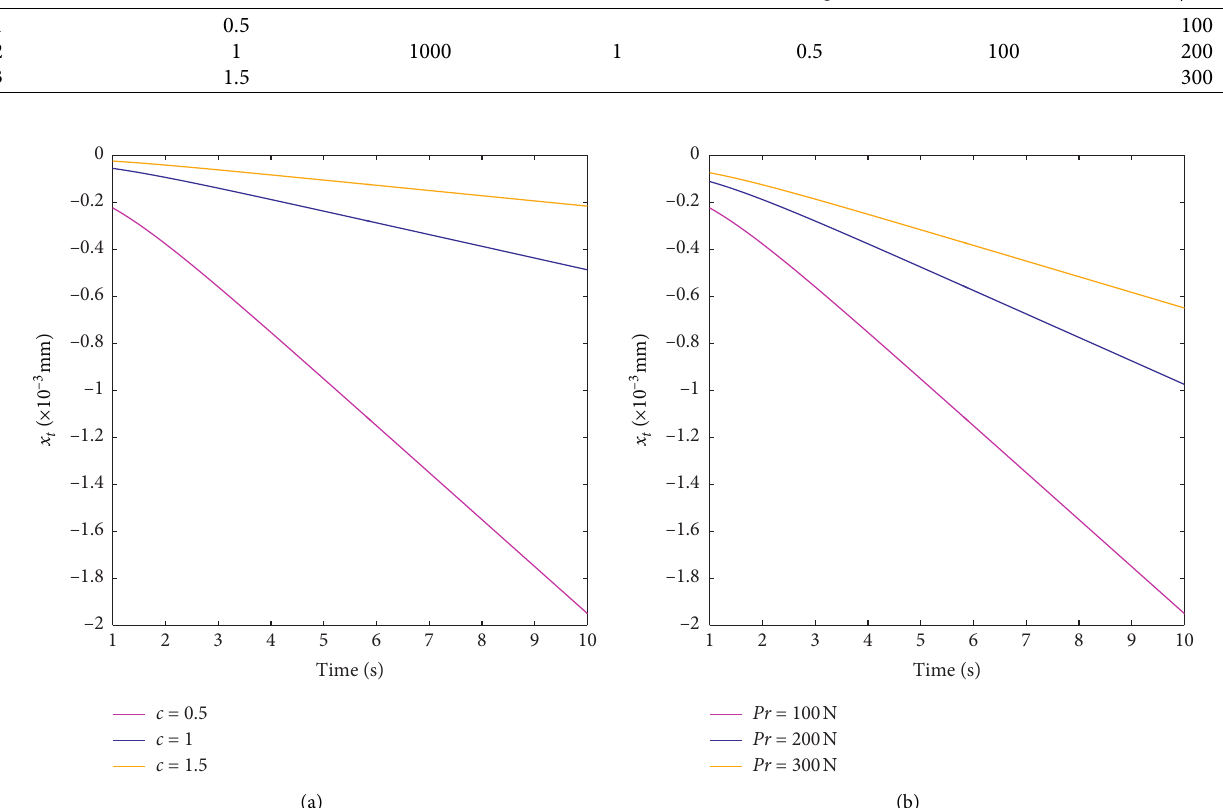
Figure 7: Changes of movement displacement of rock surface with time in different c (a) and P